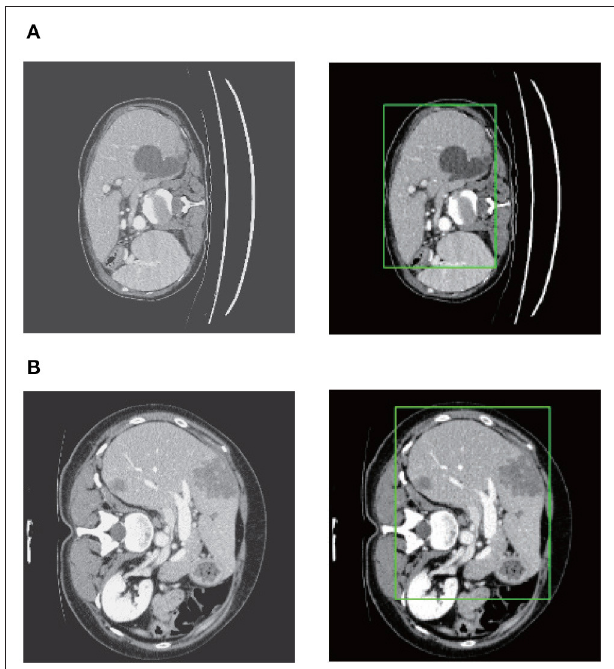
FIGURE 7 | Liver localization using RA-UNet-I. From left to right the figure shows the preprocessed slice, and the final boundary box which restricts the liver region. (A) A typical slice from the LiTS validation dataset. (B) A typical slice from the 3DIRCADb dataset. The RA-UNet-I enables the coarse localization of liver